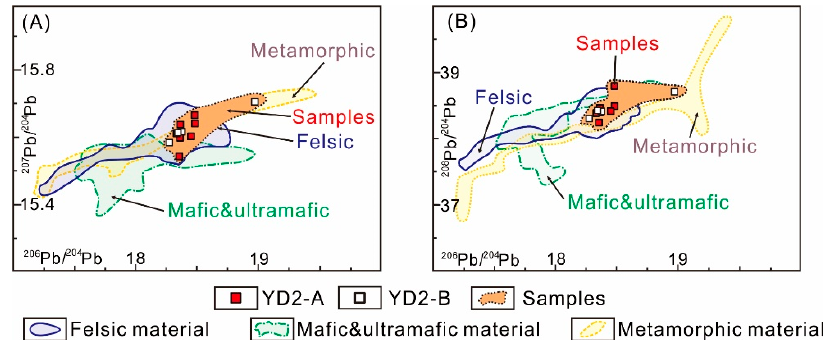
Figure 10. Lead isotope ratios of pyrite sub-samples compared with spatially- and temporally-associated materials (( A ): 207 Pb/ 204 Pb- 206 Pb/ 204 Pb; ( B ): 208 Pb/ 204 Pb- 206 Pb/ 204 Pb). Lead isotope ratios in (A) and (B) are corrected to their initial ratios. The fields of metamorphic, felsic and mafic-ultramafic are drawn according to lead isotope data of material from the literature. Lead isotope data sources: (1) felsic rocks: [50,51]; (2) mafic and ultra-mafic rocks: [52–55]; (3) metamorphic rocks: [50,56].